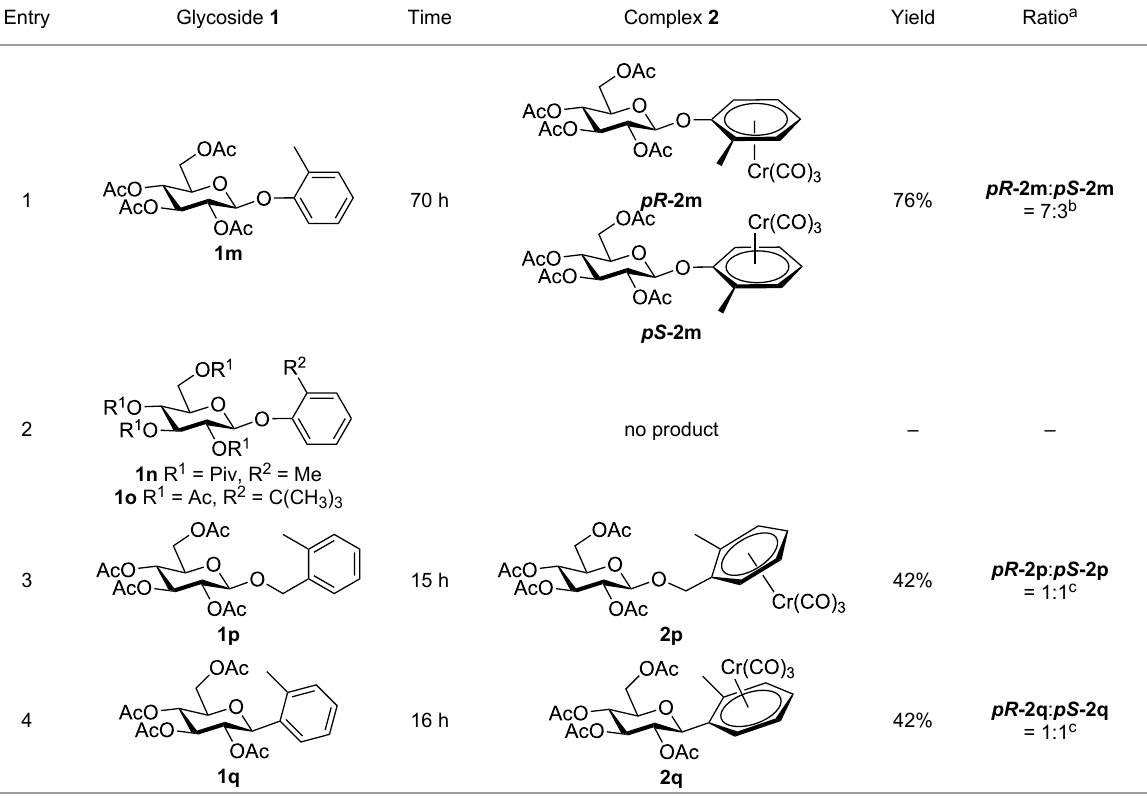
Table 2: Synthesis of tricarbonylchromium complexes 2m – q from glycosides 1m – q containing a prochiral aglycon and Cr(CO) 6 in di- n -butylether/THF 9:1 at 140 °C under Ar in the